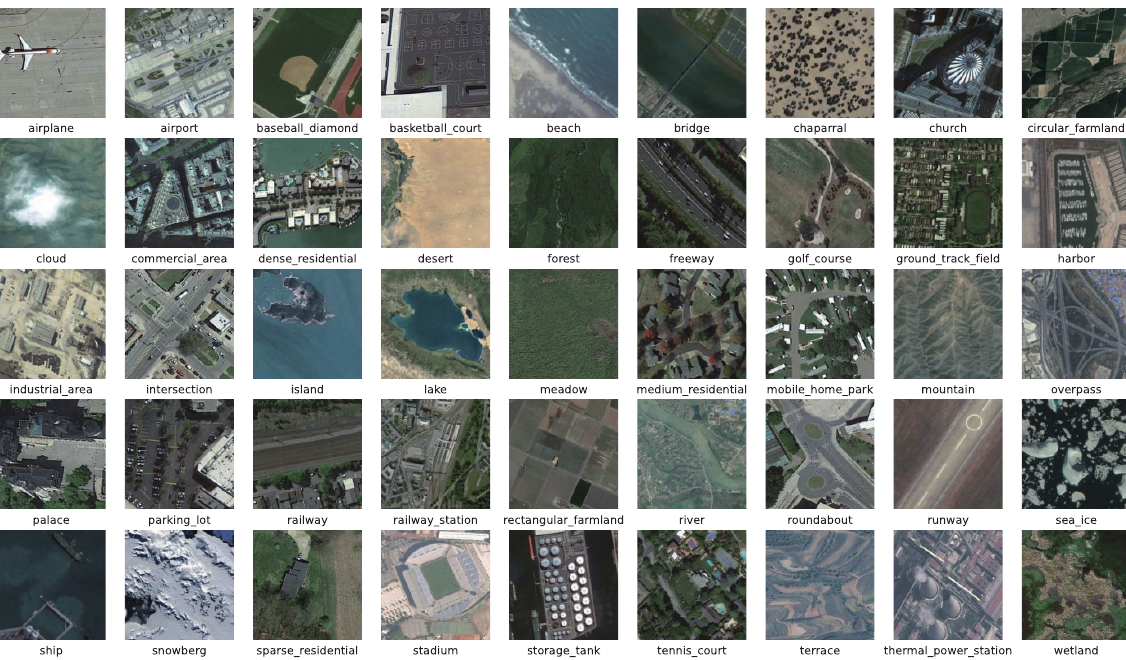
Figure 9. Some samples from the NWPU